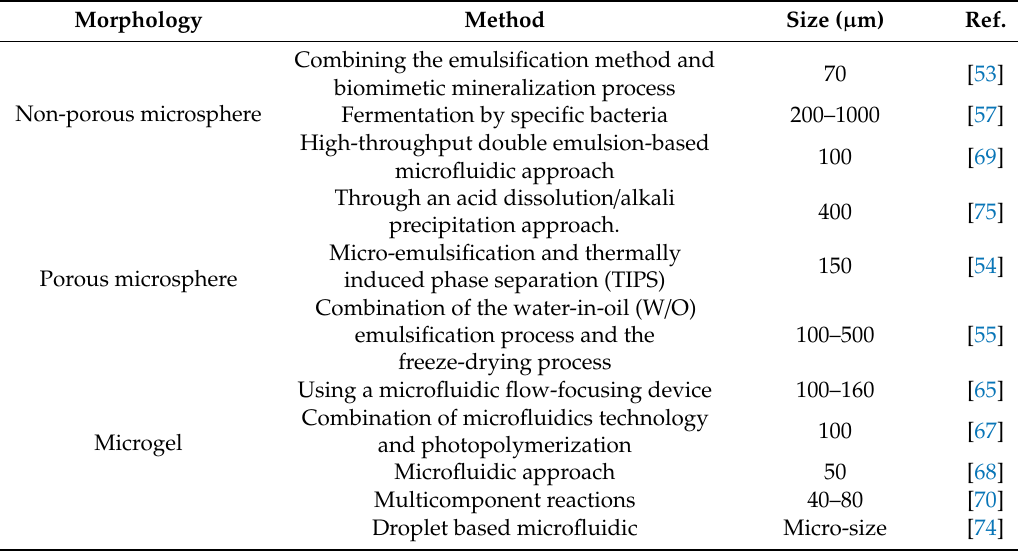
Table 1. Technology for constructing three-dimensional (3D) cell